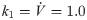
A approaches Afinal independent of the initial concentration of A.(a) A0 = 8.0; (b) A0 = 0.0. All other rate parameters are: k1=V˙=1.0, k2 = 2.0, E0 = 0.1, V0 = 20.0.